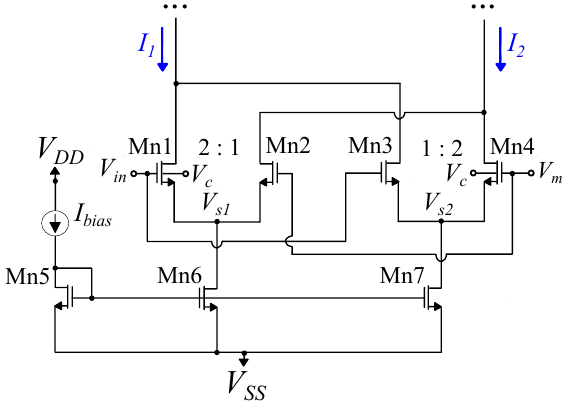
Figure 13. Transistor level implementation of ( a ) a non symmetric current correlator and ( b ) a symmetric current correlator.